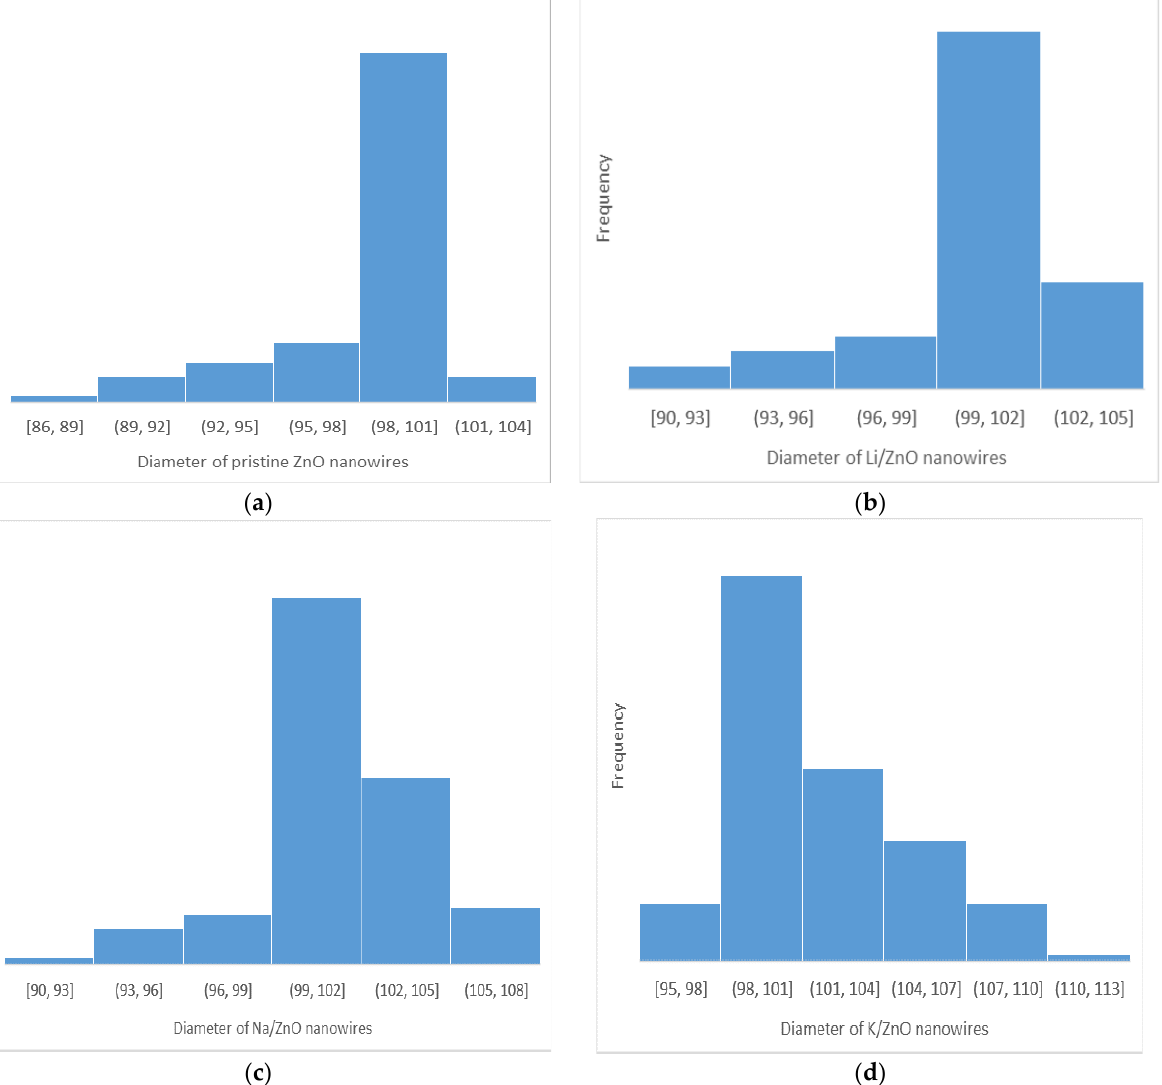
Figure 3. Histogram showing diameter range of ZnO nanowires, ( a ) pristine ZnO nanowires, ( b ) Li- doped ZnO nanowires, ( c ) Na-doped ZnO nanowires, ( d ) K-doped ZnO nanowires.